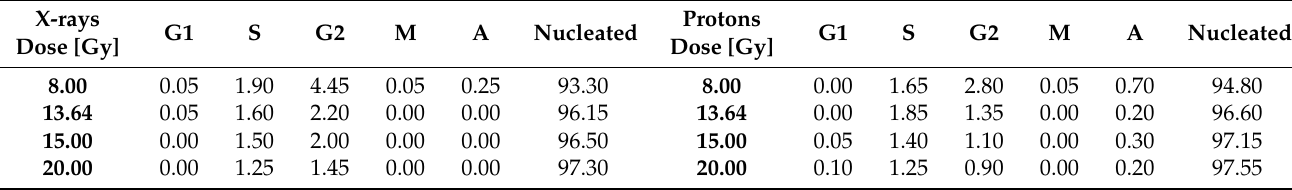
Figure 4. Frequency distribution of the number of excess fragments in cells irradiated with vari- ous doses of X-rays ( A , C , E , G ), compared to those treated with protons ( B , D , F , H ). The parameters determined for Gaussian fitting are presented in the tables located with each histogram. Table 2. Percentages of G1, S, G2, M, A phases, and nucleated cells at each dose of X-rays or protons after irradiation with various doses of X-rays or protons. Bold is necessary for showing difference between doses used and results – making it more